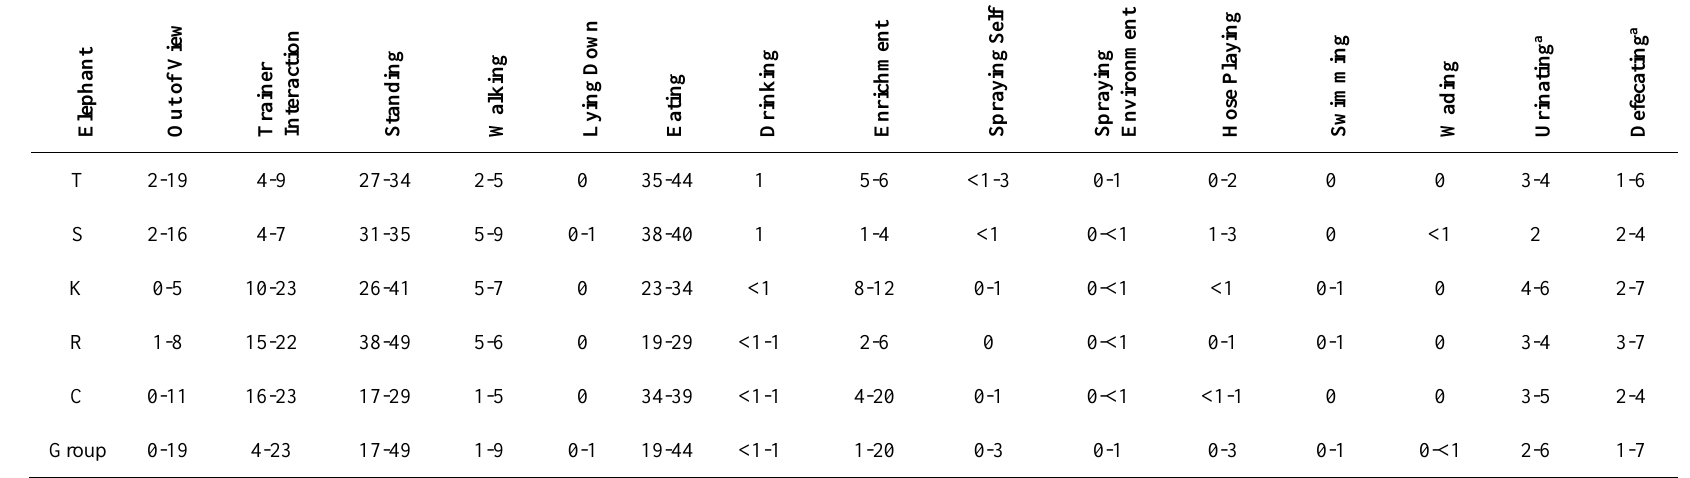
a Number of time behavior occurred during observation period.